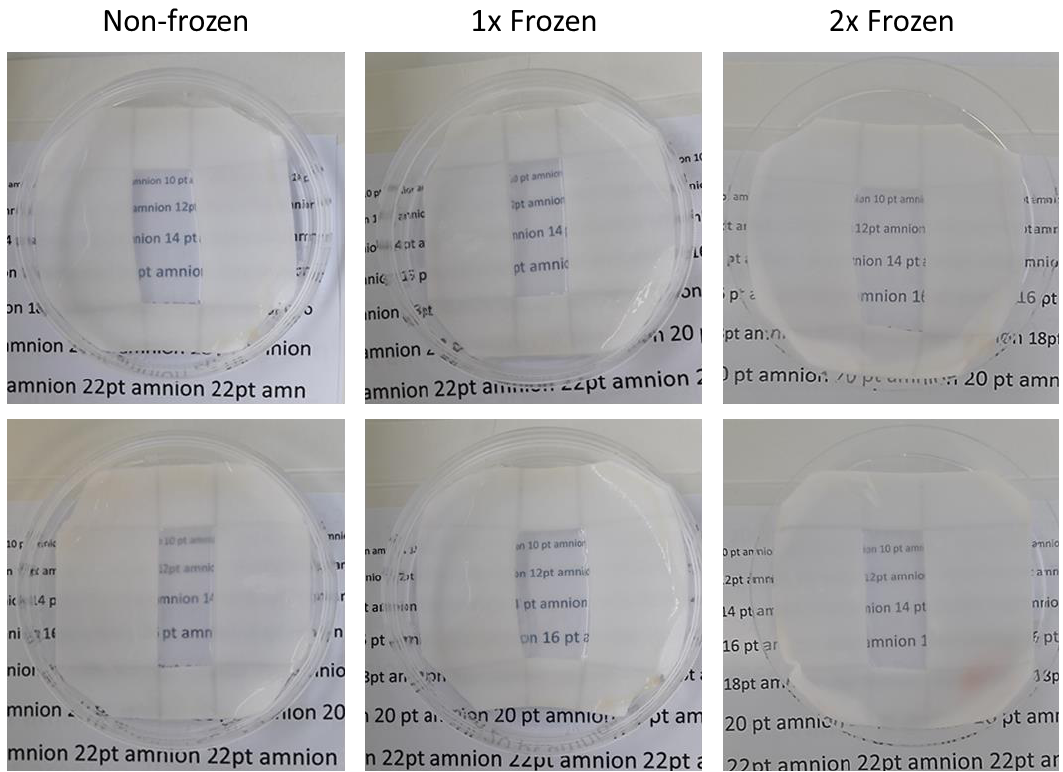
Figure 6. Transparency test. The images display the visibility of a printed text of various font sizes through non-frozen, one-time frozen (1×), and two times frozen (2×) hAMs placed on a carrier with an aperture of 15 × 30 mm over the text in a 100 mm cell culture dish.